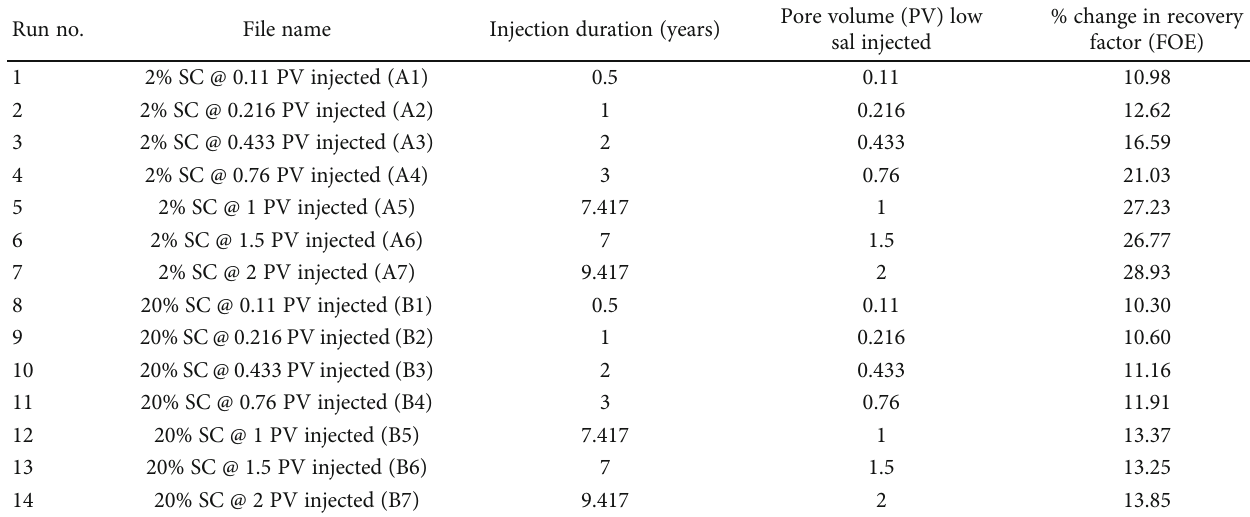
Table 7: Percentage oil recovery e ffi ciency for Case